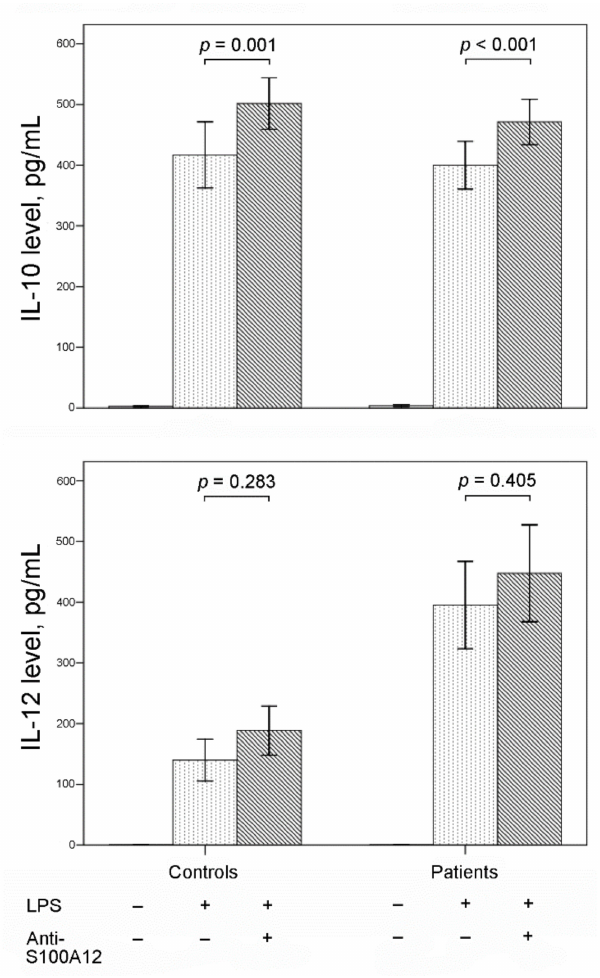
Figure 2. Bar charts with one standard error show supernatant levels of tumor necrosis factor (TNF)- α , interleukin (IL)-10, and IL-12 from peripheral blood mononuclear cells (PBMCs) with and without lipopolysaccharide (LPS) stimulation and anti-S100A12 treatment. Productions of TNF- α , IL-10, and IL-12 from PBMCs were significantly increased after LPS stimulation in both controls and patients with sepsis. Additional anti-S100A12 monoclonal antibodies increased the production of TNF- α and IL-10 in LPS-stimulated PBMCs from both controls and